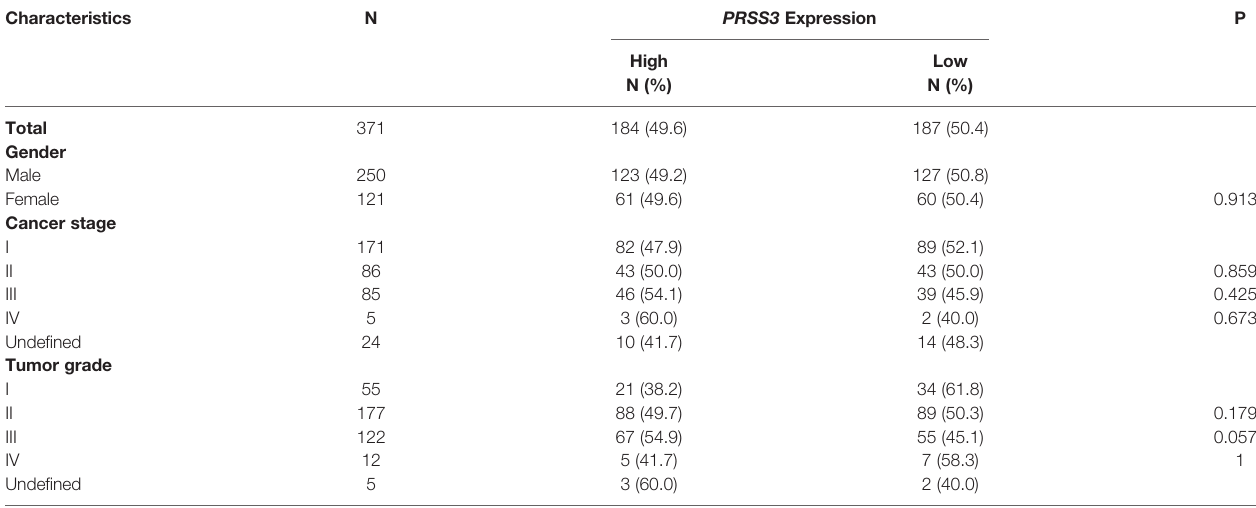
The TCGA-LIHC data (version 28/01/2016) and clinical parameters of HCC patients were downloaded from the FIREHOSE Broad GDAC. After removing 2 samples of recurrent solid tumor tissues in the dataset, the remaining 421 samples included 50 matched pairs of primary solid normal and liver tumor tissues and 321 additional tumor specimens. The RNA level of PRSS3expressionwasprocessedasTPM.HighorlowexpressionofPRSS3(PRSS3 High orPRSS3 Low )wasclassi fi edbasedonthecutoffvalueofthemedianexpressionlevelofPRSS3in the samples. The statistical signi fi cance of PRSS3 High or PRSS3 Low with clinicopathologic parameters of HCC patients was determined by c 2